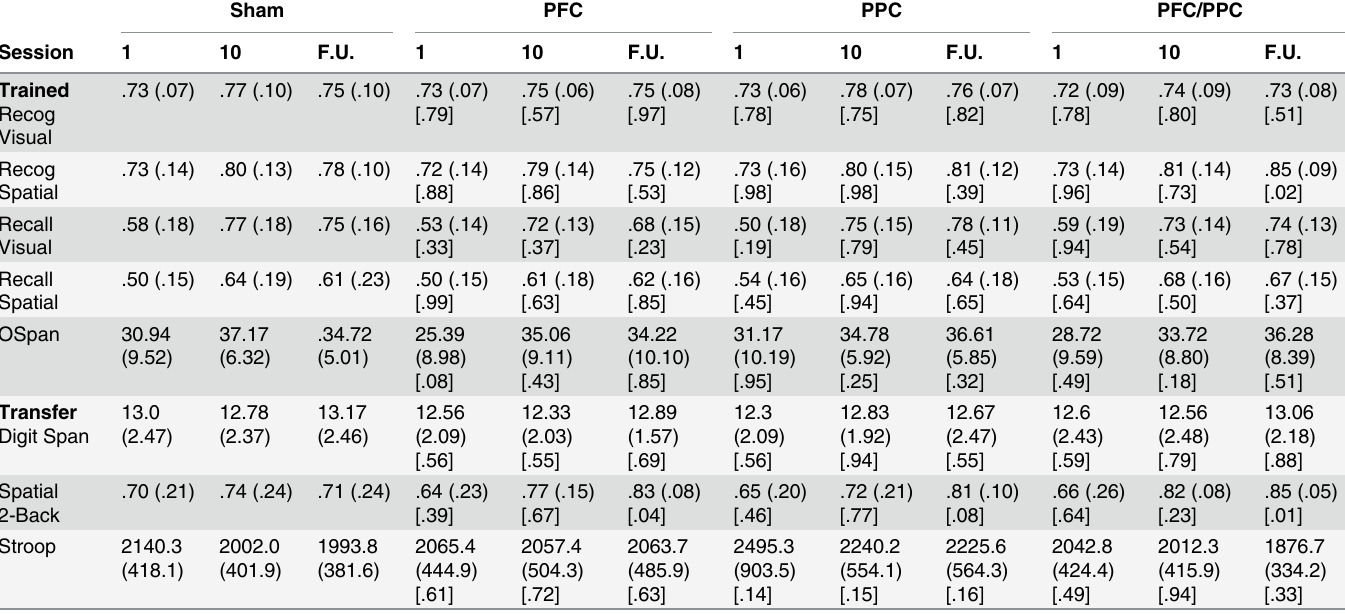
Table 1. Accuracy/scores/reaction times for the five trained tasks and three transfer tasks.